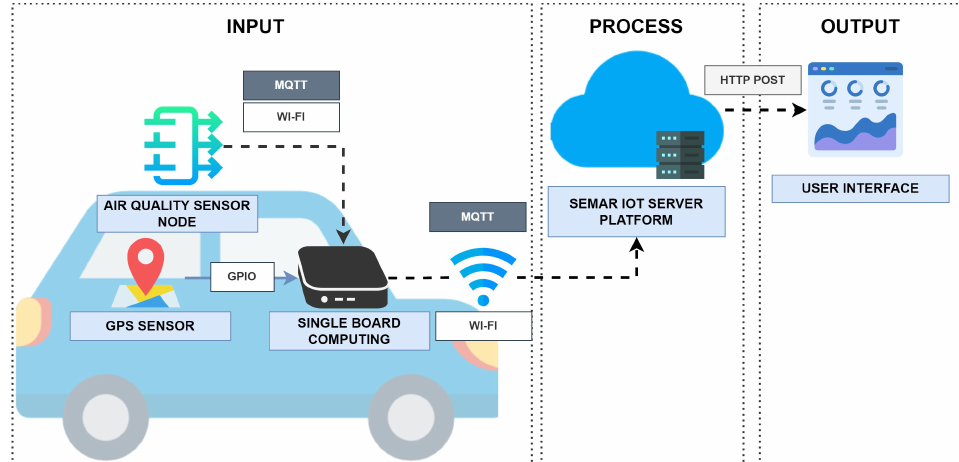
Figure 6. System overview of air quality monitoring system .